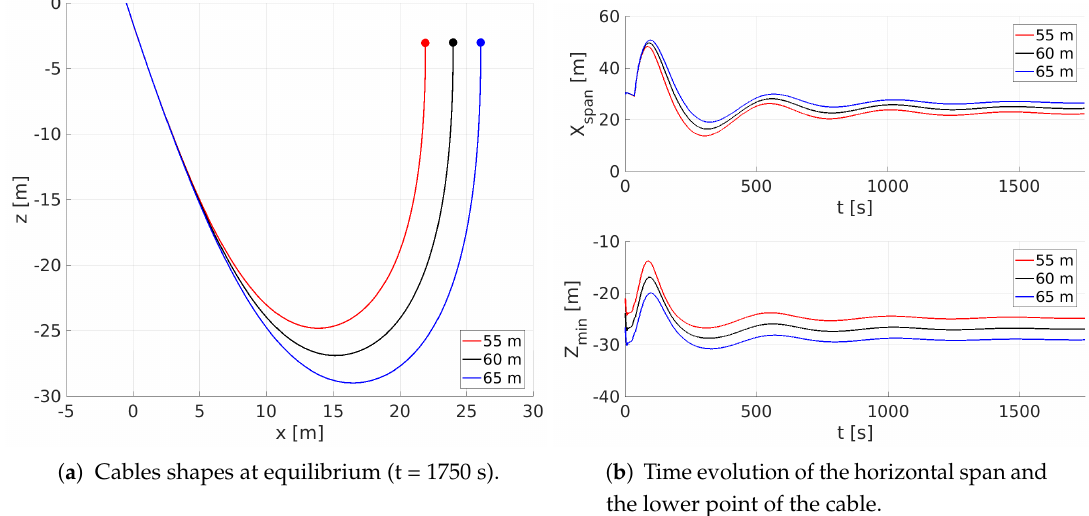
( a ) Cables shapes at equilibrium (t = 1750 s). ( b ) Time evolution of the horizontal span and the lower point of the cable. Figure 23. Floating towed bodies towed with cables of different